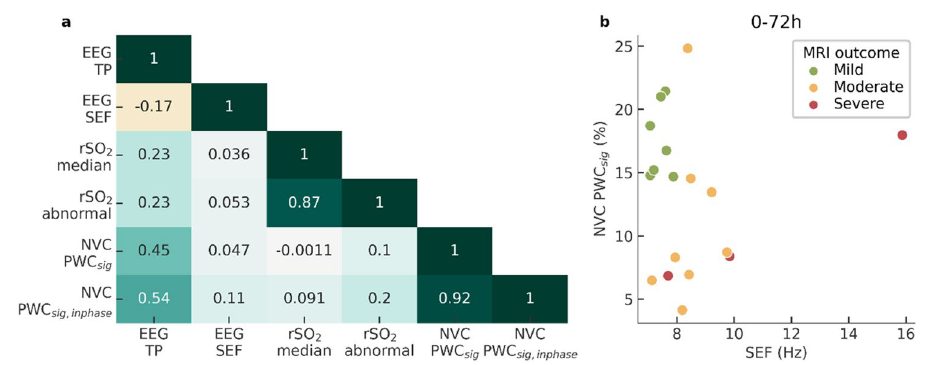
Figure 5. Relation of NVC biomarkers to EEG and NIRS biomarkers. ( a ) Correlation heat map between the features computed in the total time window (0–72 h). ( b ) EEG SEF and NVC PWC sig provide complementary information to identify neonates with mild MRI